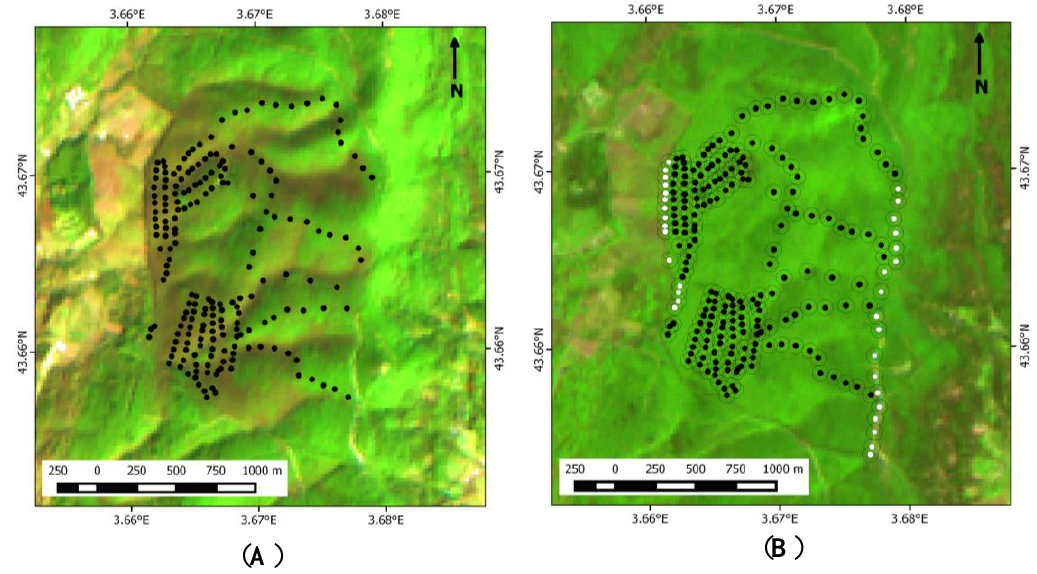
Figure 2. ( A ) Winter image (7 February 2013) of the La Rouviere study site with all 227 nestboxes indicated as black dots; and ( B ) summer image (17 June 2013) of the same study site shows nestboxes with a 50 m radius drawn around them, which corresponds to ground oak census for each nestbox. Nestboxes represented in white ( n = 33) were discarded from further analyses due to their proximity to habitat